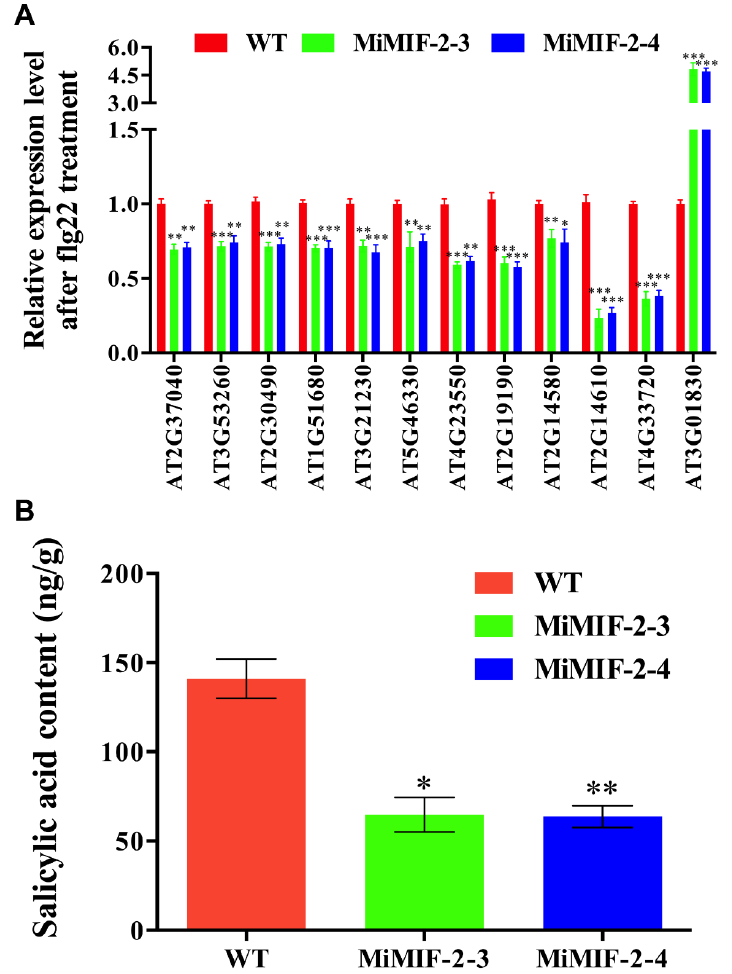
Figure 7. Candidate DEGs verification and metabolic analyses of SA content between wild type and MiMIF-2 expressing Arabidopsis after treatment with flg22 24 h; ( A ) The relative expression ratio of 12 genes involved in phenylpropanoid synthesis and plant–pathogen interaction were analyzed by RT-qPCR and normalized using UBP22 ( AT5G10790 ) as internal control. Data represent the mean fold-change ± SE. Mean values significantly different from wild type (*, **, ***) were determined by one-way ANOVA with Dunnett’s multiple comparisons test (Alpha 0.05). Three biologic repeats were performed with similar results; ( B ) SA content was quantified using seedlings of wild type and MiMIF-2 expressing Arabidopsis after treatment with flg22 24 h. The bar represents the average of three independent measurements. *, ** indicating the significant difference from the wild type was determined in one-way ANOVA with Dunnett’s multiple comparisons test (alpha 0.05).